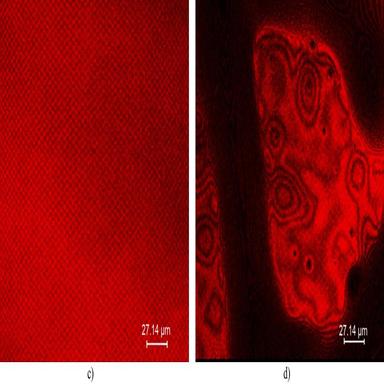
CLSM fluorescence images: a) DGH, b) DGW, c) OGH and d) OGW specimens.